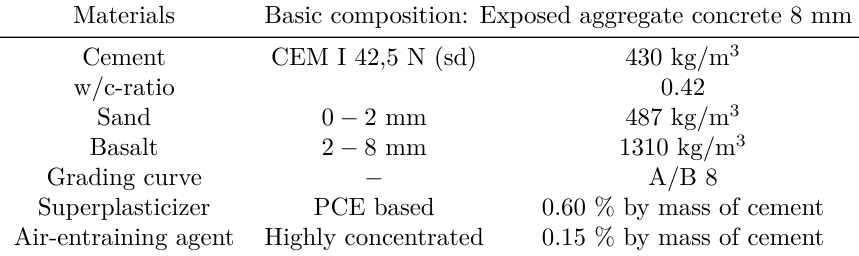
Table 1. Concrete Mix